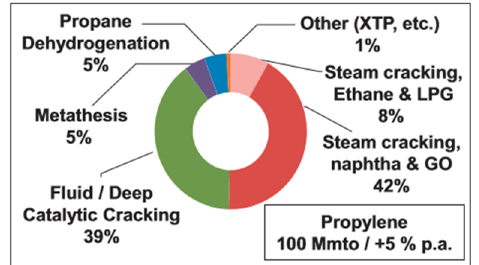
Figure 3. C 3 H 6 production methods using hydrocarbon feedstocks. Reproduced from [3]. 2014,